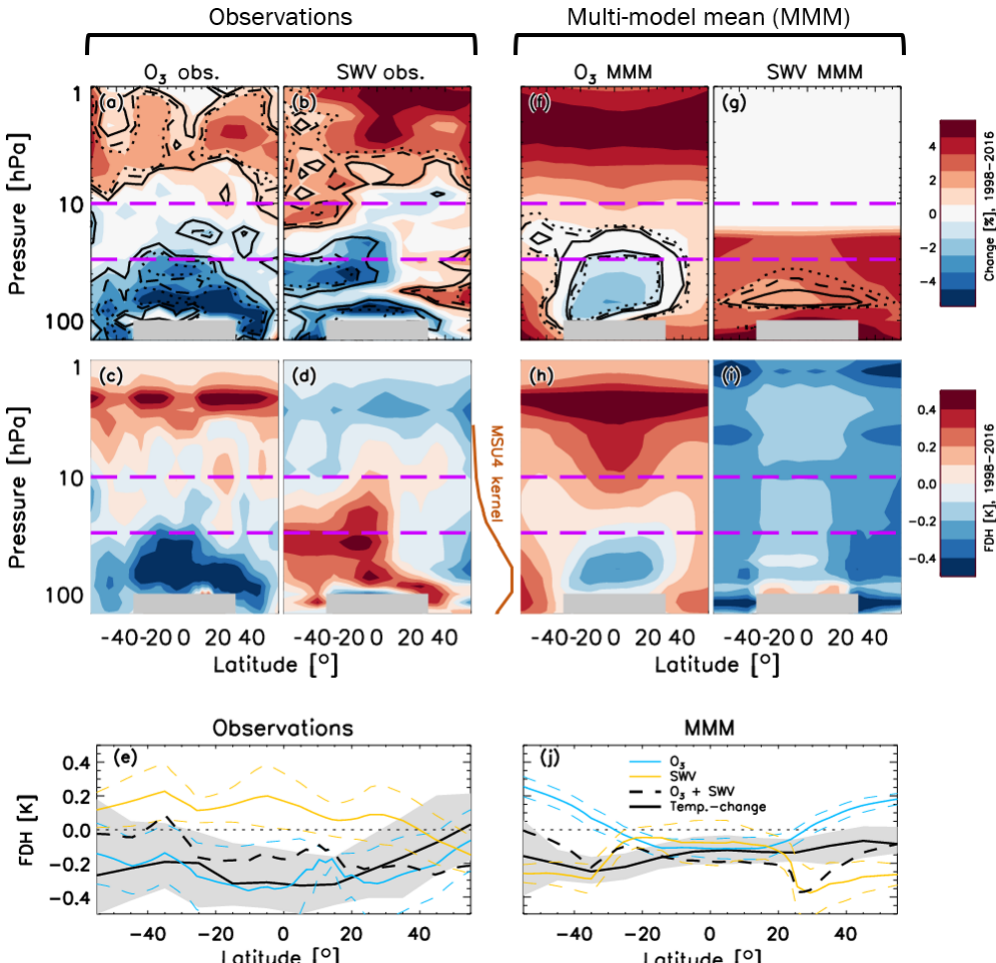
Figure 5. Fixed dynamical heating estimate of ozone and SWV contribution to lower stratosphere temperature changes. (a–e) Observed and (f–j) MMM estimates for (a, f) ozone and (b, g) SWV changes (right legend), with the corresponding spatially resolved FDH-estimated contributions to temperature changes from (c, h) ozone and (d, i) SWV temperature. (e, j) After applying the MSU4 observing kernel, the estimated latitudinal contribution to MSU4 temperature changes with 68% credible intervals; the MSU4 kernel (Randel et al., 2009b) is plotted between (d) and (h)